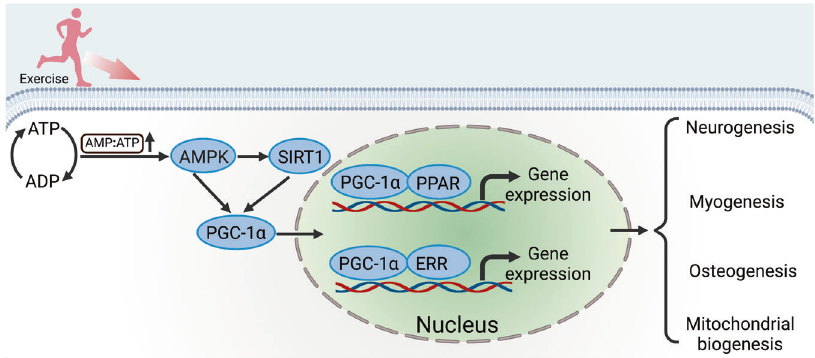
Fig. 5 AMPK/SIRT1/PGC-1 α signaling pathway. Exercise changes the energy status, consuming a large amount of ATP, which elevates AMP-to- ATP ratio. Consequently, AMPK/SIRT1/PGC-1 α signaling pathway is activated. PGC-1 α is very important in the anabolic process of exercise- induced response. PGC-1 α and PPAR/ERR form co-transcriptional complexes that initiate the overexpression of target genes, thereby promoting tissue regeneration and repair, including neurogenesis, myogenesis, and osteogenesis. Created with